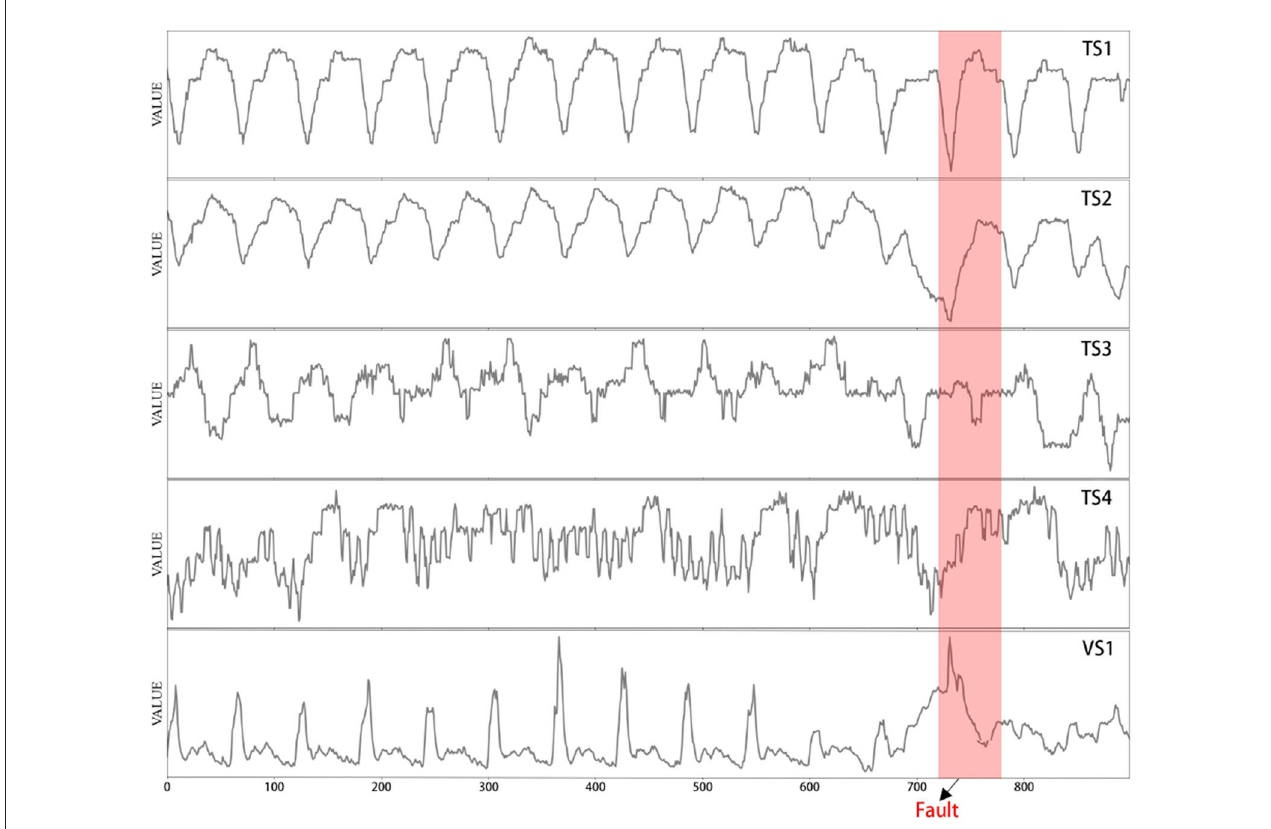
FIGURE1 Time-series metrics of four temperature sensors (TSs) and one pressure sensor (VS) in 15s, with one fault region highlighted in red (Helwig et al.,